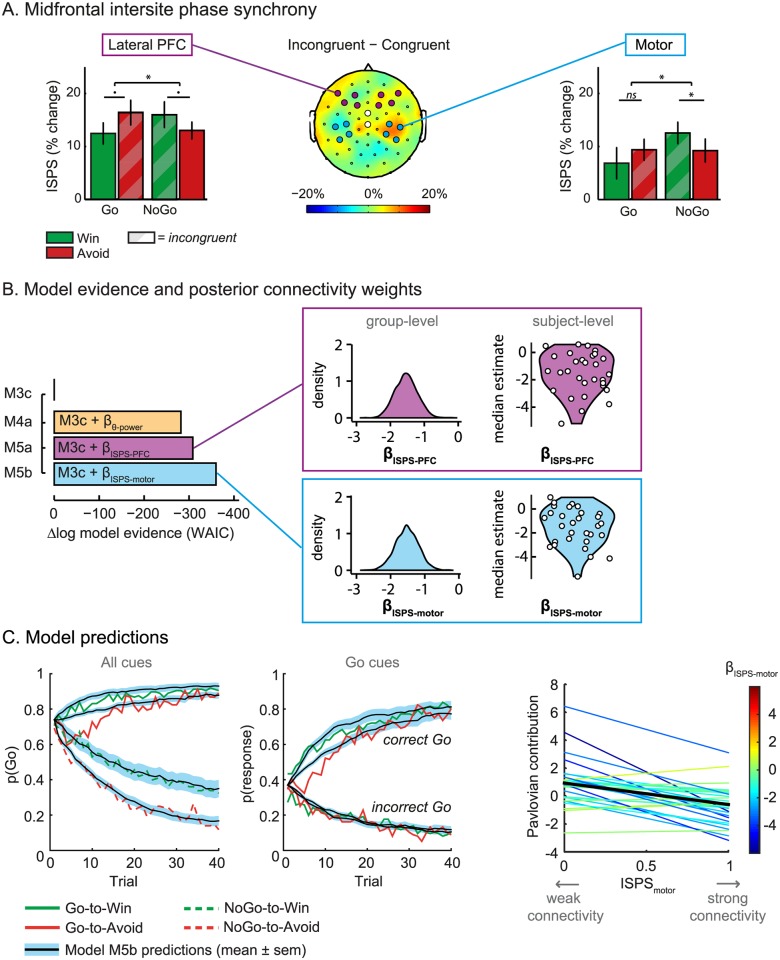
Midfrontal ISPS with lateral prefrontal and motor sites.(a) Left: Midfrontal–lateral prefrontal phase synchrony increased for motivationally incongruent cues relative to congruent cues (p = 0.018). *p < 0.05; •p < 0.1. Middle: Topographic distribution of ISPS for incongruent relative to congruent trials. The midfrontal channels showing the congruency effect of interest (see Fig 3) serve as a t-weighted seed cluster (white discs). The lateral prefrontal and motor target channels are indicated with purple and blue discs, respectively. Here, we report the nonexecuting motor channels for simplicity (see S6 Text for an in-depth discussion of the executing motor sites). Note that all subjects were right-handed, which might explain the somewhat lateralized ISPS over the motor cortex. Right: Motor–midfrontal ISPS also increased with motivational incongruency (p = 0.029). (b) Model evidence relative to winning behavioral model M3c. Model evidence improves even further for the models in which midfrontal–prefrontal (βISPS-PFC; M5a) or midfrontal–motor (βISPS-motor; M5b) phase synchrony scales the Pavlovian bias compared to local, midfrontal theta power scaling the Pavlovian bias (βθ-power; M4a). The novel βISPS-PFC and βISPS-motor parameter estimates are negative (group-level both: 100%), indicating the synchrony relates to reduced Pavlovian biases. (c) Left: M5b model predictions (black lines; shaded areas indicate the standard error of the mean) resemble the behavioral data (colored lines). The improvement in model predictions by the βISPS-motor parameter is particularly apparent for the NoGo cues. Right: Effect of midfrontal–motor connectivity on the Pavlovian contribution for all individuals (colored lines). Across the group (black line), stronger midfrontal–motor connectivity reflects improved ability to reduce the Pavlovian contribution. Underlying data can be found at http://hdl.handle.net/11633/di.dccn.DSC_3017033.03_624. ISPS, intersite phase synchrony; PFC, prefrontal cortex; WAIC, Watanabe–Akaike Information Criterion.